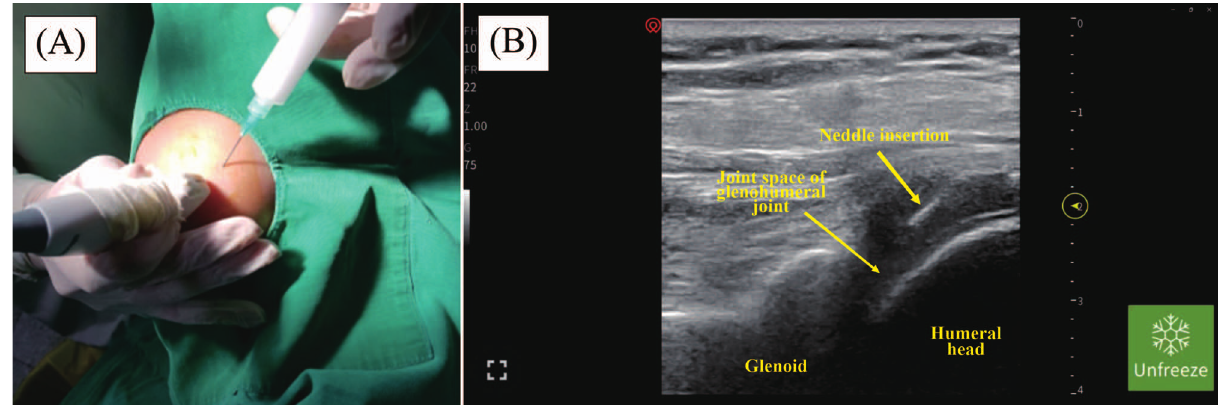
Figure 2. Identi fi cation and glenohumeral hydrodilatation on frozen shoulder. A posterior approach for glenohumeral joint injection created an anatomical landmark approximately 1 – 2 cm below the posterolateral acromion and shifted to the medial, short-axis probe position (A). Echogenic needle insertion in-plane position from the lateral to the medial, penetrating the infraspinatus muscle and posterior capsule, injecting the steroid (40 mg triamcinolone acetonide) as 15 – 20 mL aquabidest (B).